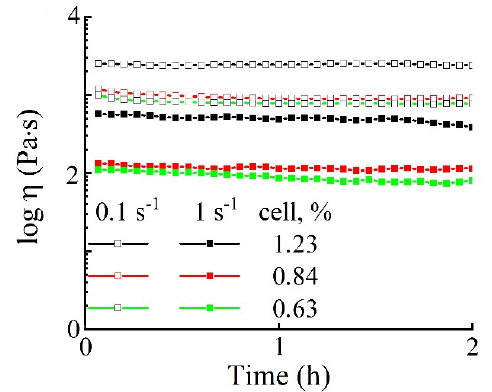
Figure 5. The time dependences of viscosity of dispersions with di ff erent BC content (indicated in figure) at shear rates of 0.1 and 1 s − 1